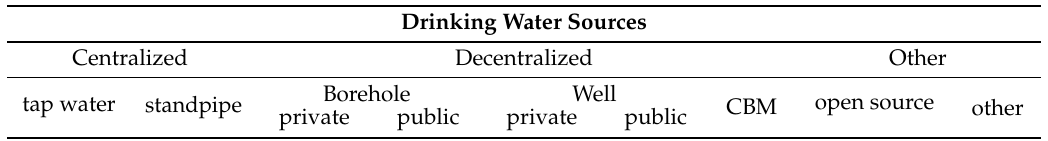
Table 1. Drinking water sources in northeast rural